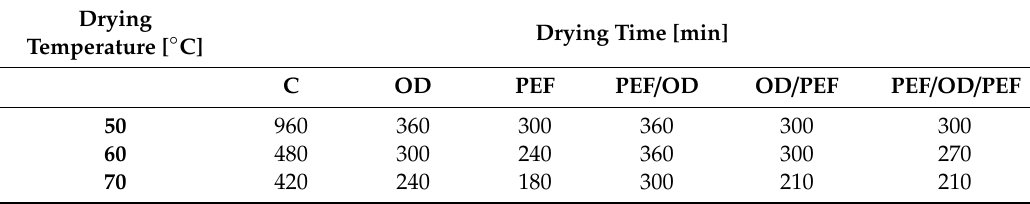
Table 2. Total drying time (min) of the di ff erently pre-treated kiwifruit slices at the di ff erent temperatures (50, 60 and 70 ◦